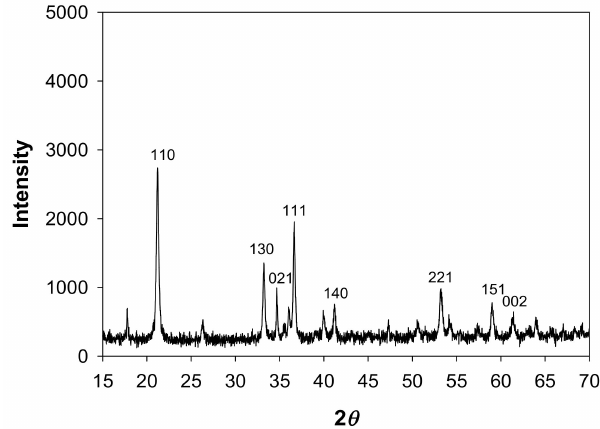
Figure 1. X-ray di ff raction (XRD) of synthesized